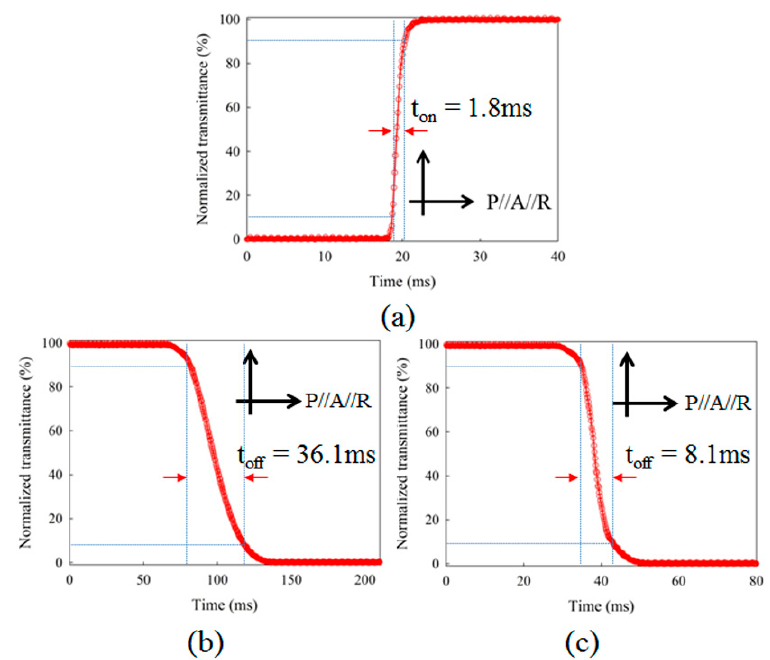
Figure 10. On/Off response times of the LC layer of the DFPG. ( a ) Field-on response time; ( b ) Field-off response time obtained by the natural relaxation of the LC layer due to the surface alignment effect without applying any electric field; ( c ) Off response time obtained by applying a high frequency field to the LC layer utilizing the frequency inversion effect of the LC dielectric anisotropy.